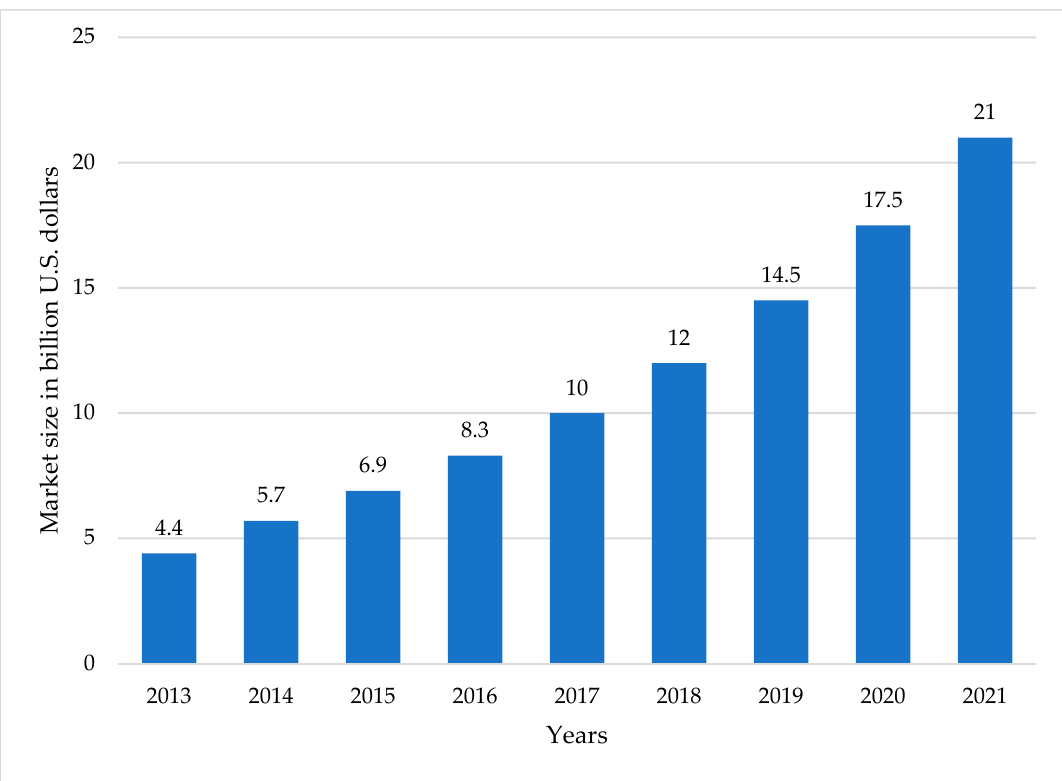
Figure 1. The 3D printing process (adapted with permission from reference [18]).